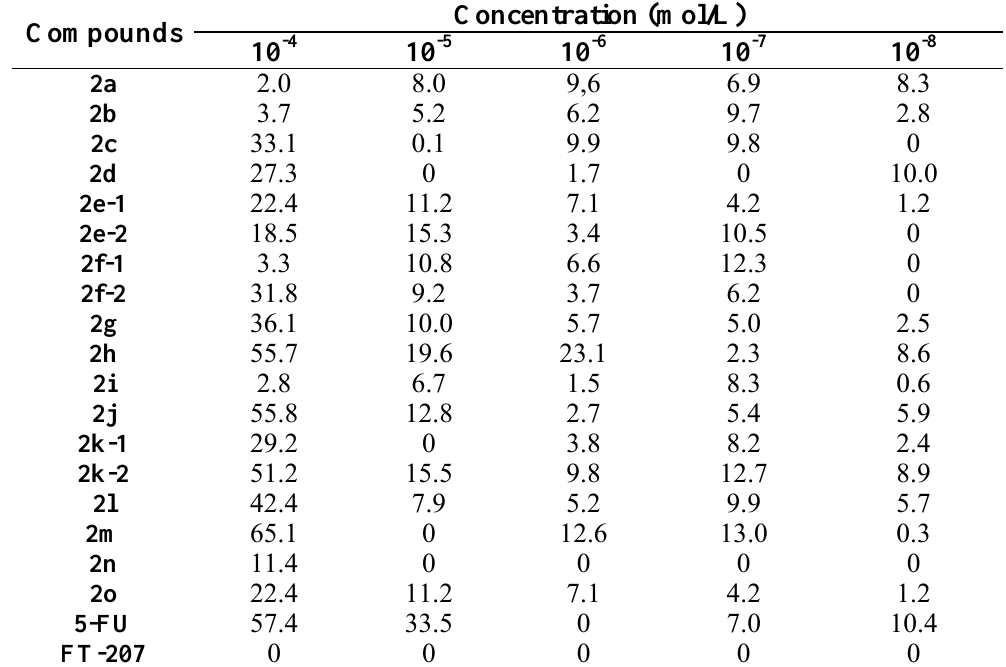
Table 1. Inhibitory rates (%) against HL-60.